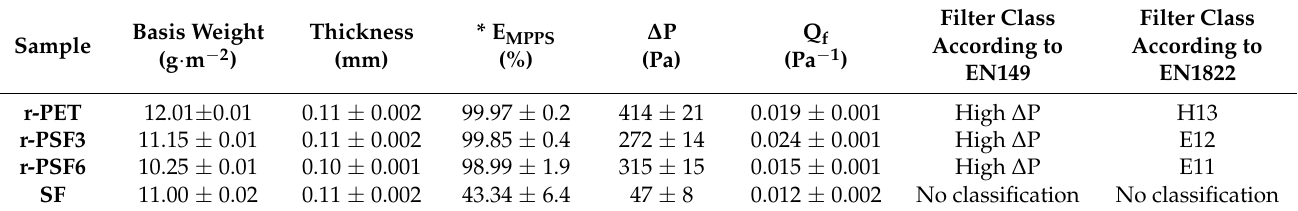
Table 4. List of results from the filtration activity of investigated fibrous mats: SF pure, r-PSF3, r-PSF6, and r-PET pure. The basis weights of the investigated mats were between 10–12 g · m − 2 . The membranes were classified according to Standard EN149 and EN1822. The values are listed in the form mean ± SD (standard deviation).